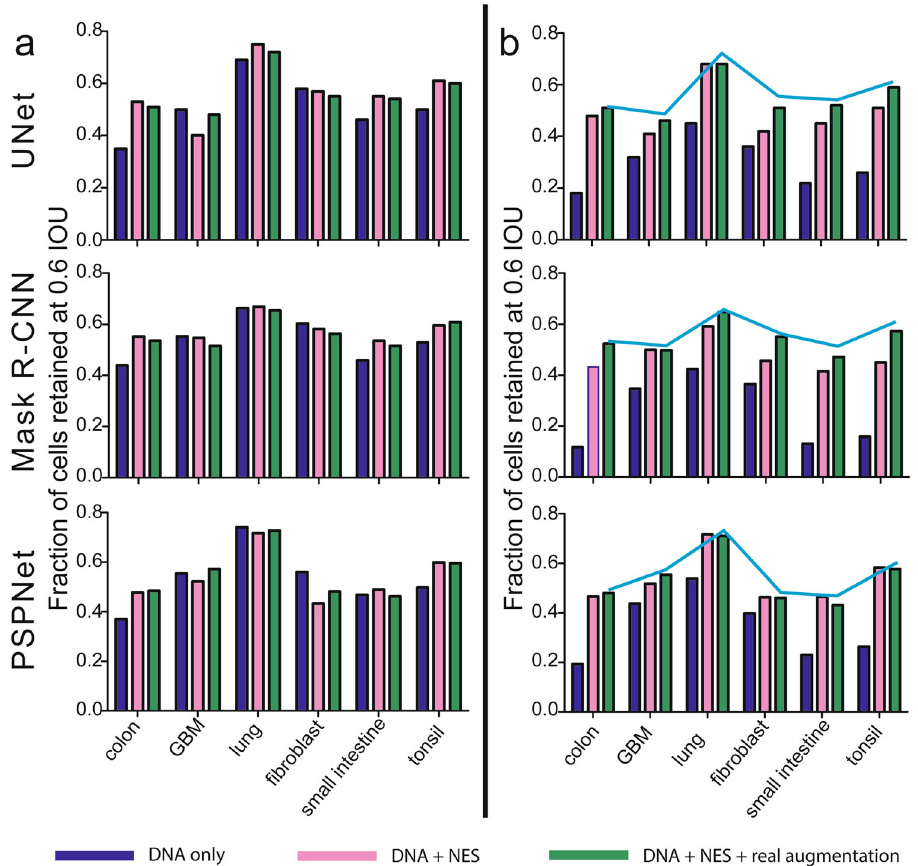
Fig. 5 Assessing different training strategies on (a) in-focus and (b) defocused test data for different tissue types. a In all tissue types apart from GBM, the addition of NES (pink bars) and the use of real augmentations combined with NES (green bars) in training data offered superior accuracy compared to using DNA alone (blue bars). b When the models were tested on defocused data, all tissues (including GBM unexpectedly) showed bene fi ts resulting from using NES (pink bars) combined with real augmentations (green bars). The line plot indicates highest accuracy achieved for each tissue when tested on in- focus data from panel ( a